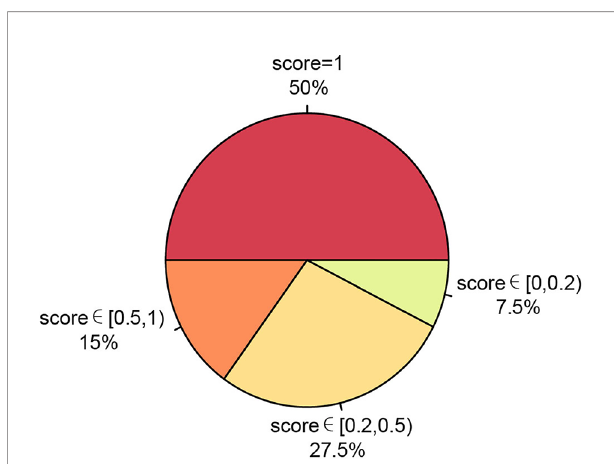
FIGURE 4 | Summary of our method's performance on 13 cancer types data set without allele frequency. The consistency between PTI and original results based on similarity scores were represented as a pie